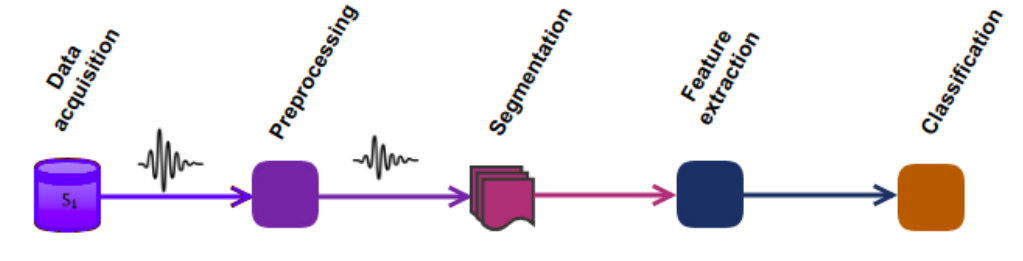
Figure 1. Human activity recognition process.